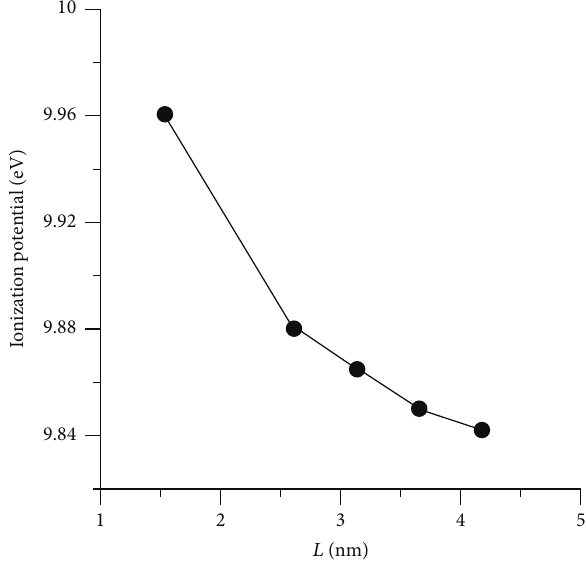
Figure 4: Dependence of the ionization potential on the graphane nanoflake